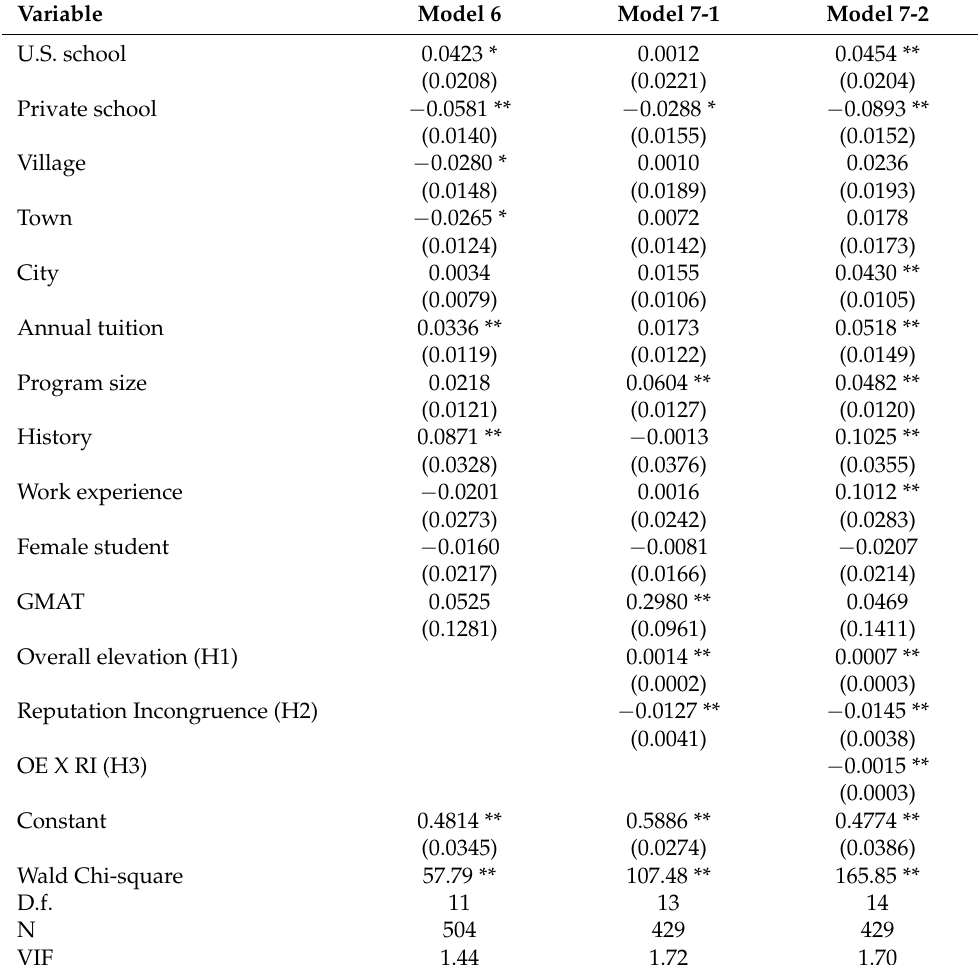
Table 5. GEE estimates of weighted salary,